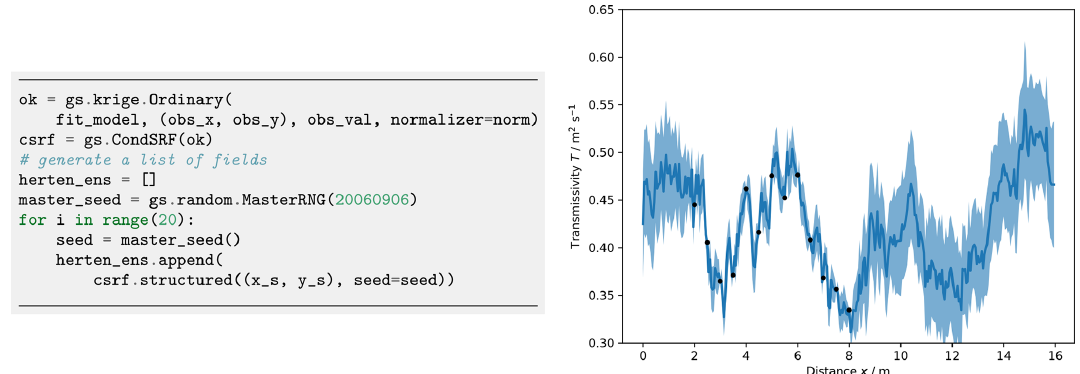
Figure 30. Generation of an ensemble of 20 conditional realizations and transmissivity transects T (x) at y = 4m. The thick blue line is the true transmissivity (Fig. 27), and the shaded area shows the range of 1 standard deviation calculated from 20 realizations of conditioned fields. Black points indicate the